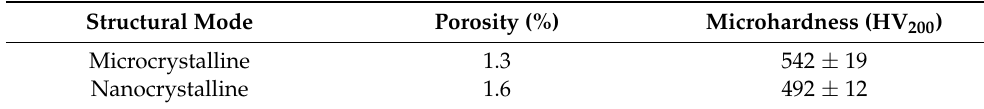
Table 3. Percentage of porosity (%) and microhardness (in HV) of the APS deposited HEA AlCrFe- CoNi